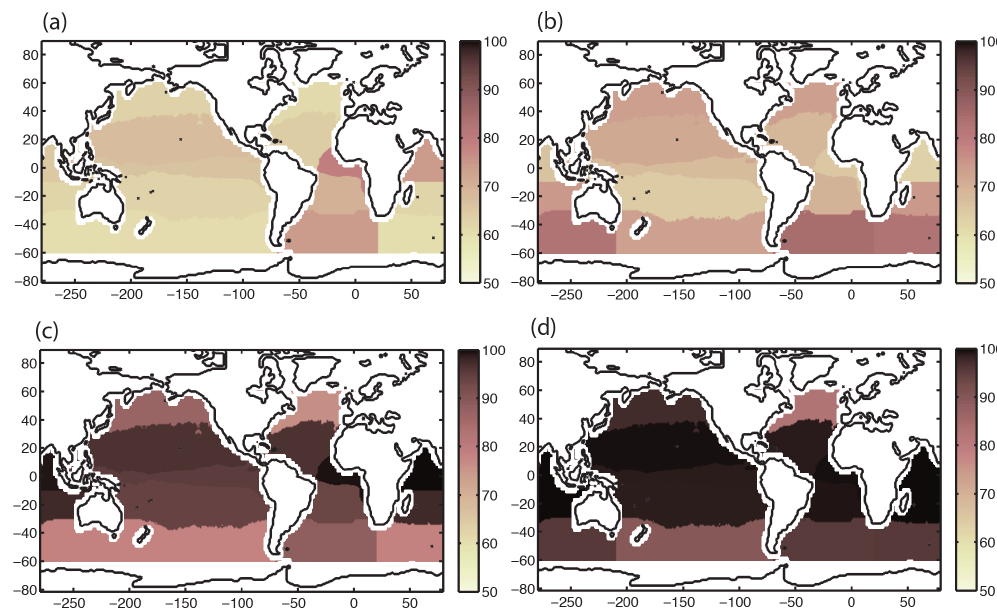
Figure 4. Confidence intervals for two 10-year intervals, namely 2005–2014 (left column), and 2075–2084 (right column). The confidence intervals for (a) the four drivers ( (cid:127) arag , SST, O 2 inventories, and NPP) over 2005–2014 are taken as the average over the fields shown in Fig. 2, and (b) the confidence intervals shown for the four drivers over 2075–2084 are taken as the average of the fields shown in Fig. 3. This is then considered for the case of the dominant two drivers in (c) for the period 2005–2014, and in (d) for the period 2075–2084. Finally, the confidence intervals averaged for the dominant two drivers are shown in (e) over 2005–2014 and (f) over